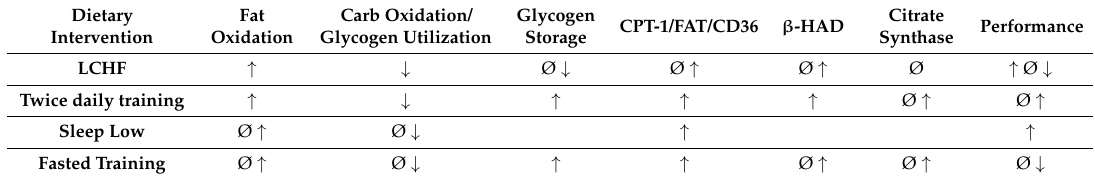
Table 1. Summary of adaptations to concurrent diet and endurance training strategies. Abbreviations and symbols: FAT/CD36: fatty acyl translocase; CPT-1: carnitine palmitoyltransferase-1; β